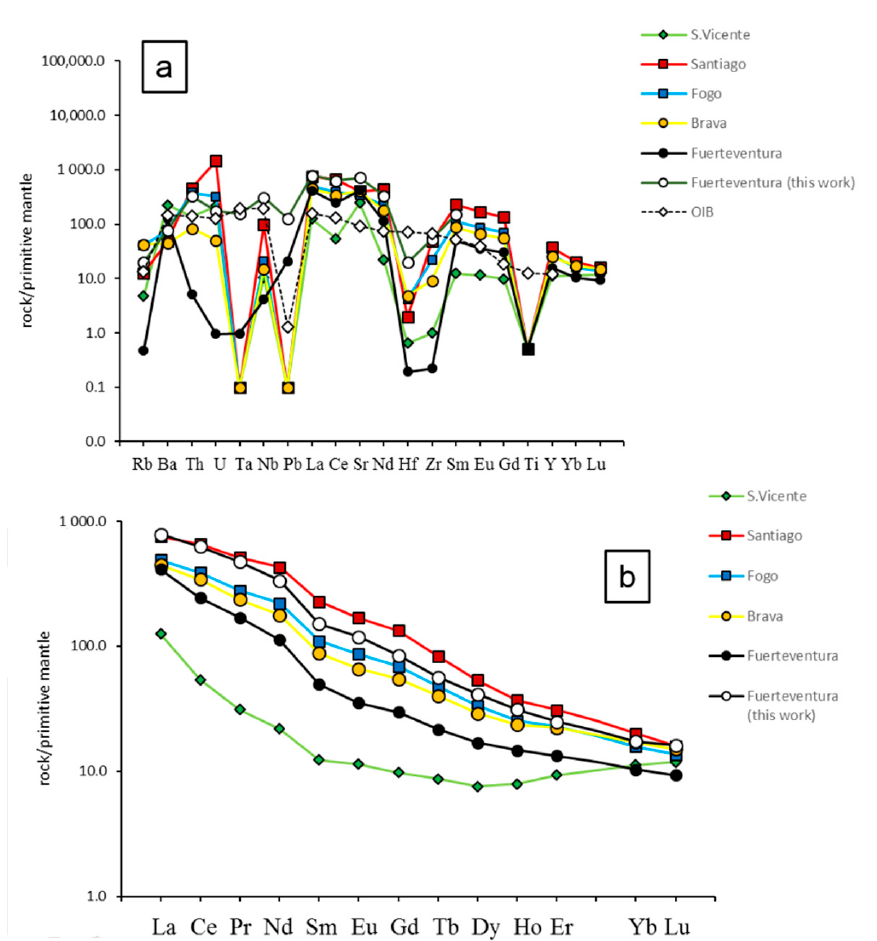
Figure 3. ( a ) Multi-element and ( b ) REE abundance diagram normalized to the primitive mantle of McDonough and Sun 1995 [78], showing patterns of representative samples of Fuerteventura and Cape Verde carbonatites (from Hoernle et al. 2002 and Doucelance et al. 2010, respectively [12,20]). Ocean island basalt (OIB) from Sun and McDonough 1989 [79].